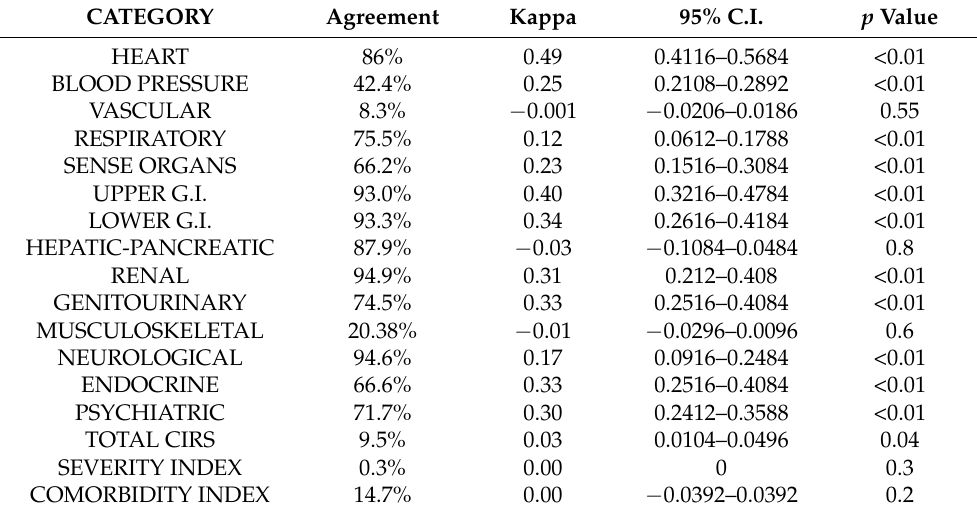
Figure 3. Concordance between epidemiologists and ward doctors (first control). Table 1. Levels of agreement between the CIRS values reported by the pool of epidemiologists and ward doctors (first